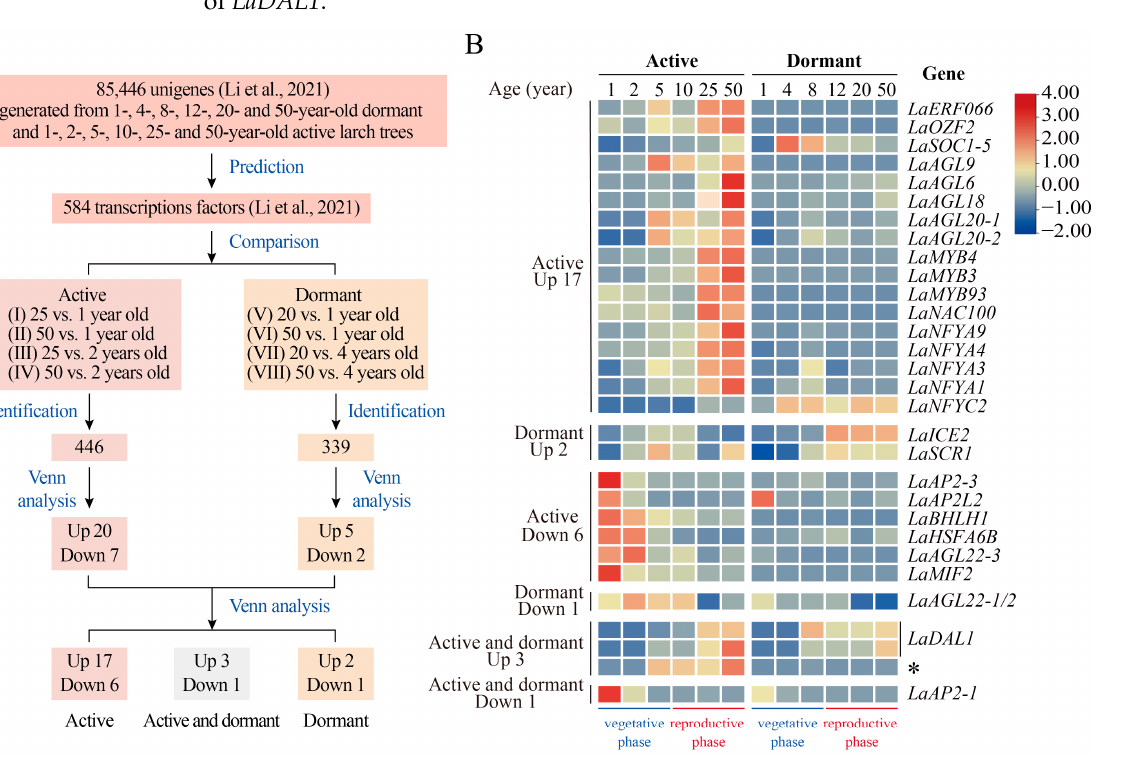
Figure 1. Identification and annotation of 30 differentially expressed transcription factors. ( A ) Ana- lytical flowchart of differentially expressed transcription factors. Branches produced in 2012 were collected from the upper crowns of 1-, 4-, 8-, 12-, 20-, and 50-year-old dormant Larix kaempferi trees on 10 March 2013 for transcriptome sequencing [7]. The uppermost main stems produced in the current year had been collected from 1-, 2-, 5-, 10-, 25-, and 50-year-old active L. kaempferi trees in July 2011 [8] for transcriptome sequencing [9]. After the removal of buds or needles, the left stems from at least three trees from each age category were pooled and used for RNA extraction. A total of 85,446 assembled unigenes generated from our previous study were used to predict the transcrip- tion factors [7]. In the active and dormant phases, the transcript levels of transcription factors in the juvenile vegetative (1-, 2-, and 4-year-old) and adult reproductive (20-, 25- and 50-year-old) phases in L . kaempferi were compared. ( B ) Heatmap showing the expression patterns of 30 differentially expressed transcription factors assayed by RNA-Seq. Among the 30 transcription factors, the full- length cDNAs of nine were cloned [2,7,10,11] and the sequences of two were almost the same, so the full-length cDNAs of the left 19 were cloned here (Supplemental Table S1). (* transcript not cloned in this study). ( C ) Statistics of differentially expressed transcription factors and unigenes. To approach these questions, we assessed LaDAL1 transcription using materials at different phases of the annual growth cycle. Based on the expression pattern of LaDAL1 , three stages were distinguished (Figure 2A). LaDAL1 transcript level was low in stage I